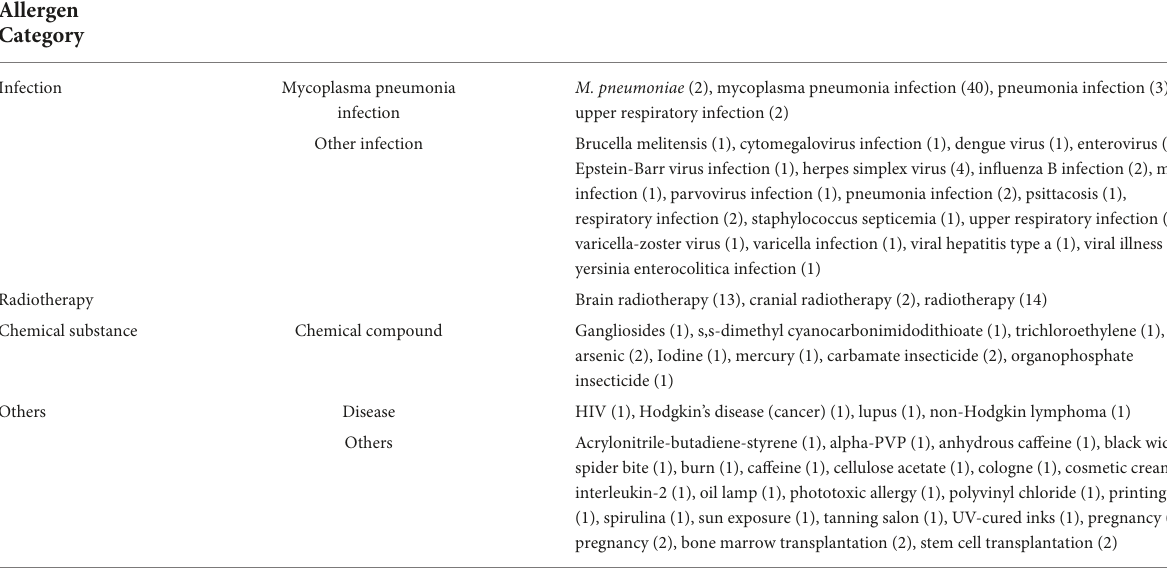
TABLE 6 Non-drug allergen category and non-drug allergen with case count. Non-Drug